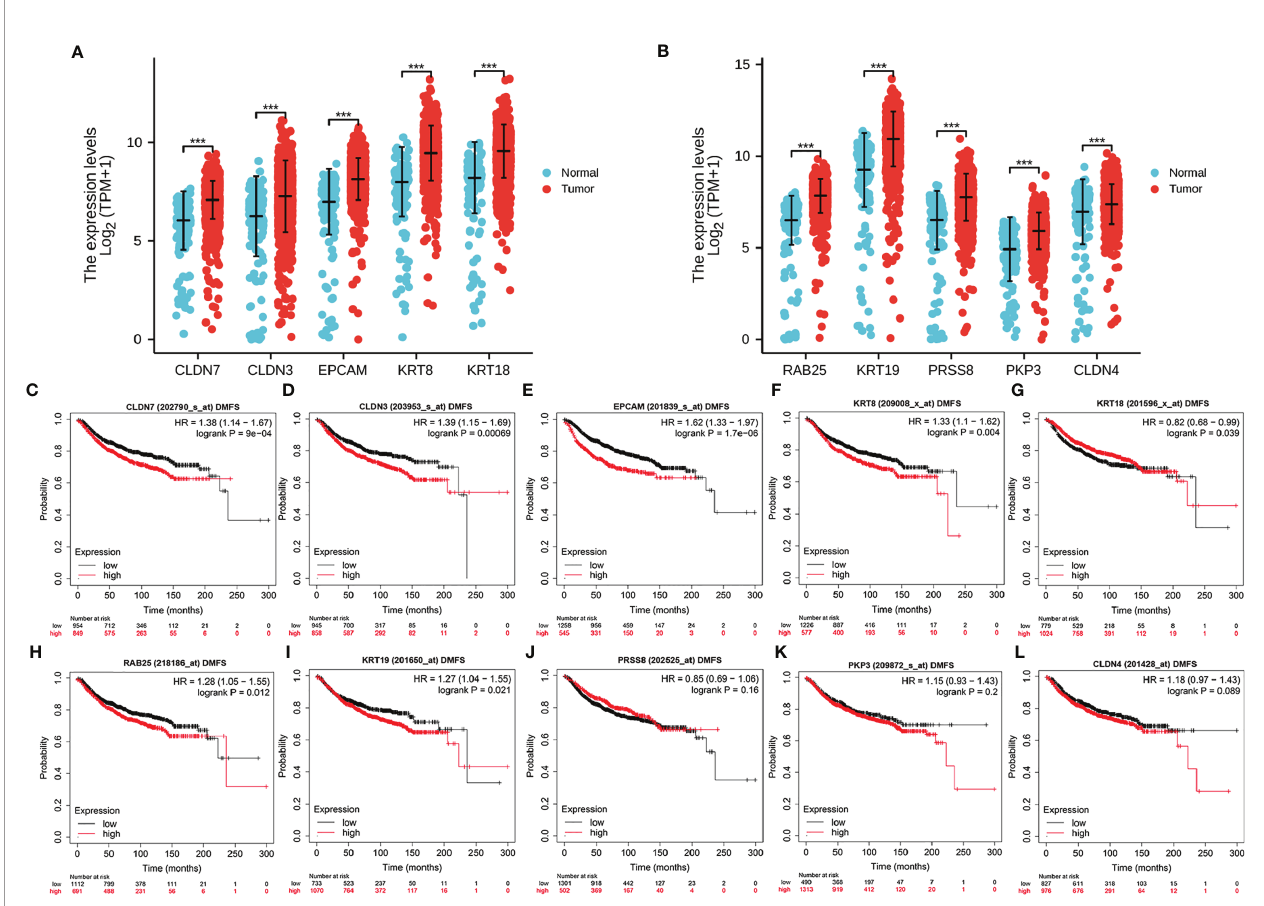
FIGURE 9 | Expression and prognostic signi fi cance of the hub genes in TCGA. Differential expression of the 10 hub genes (A, B) in breast cancer. The correlation between patient DMFS and the expression of CLDN7 (C) , CLDN3 (D) , EPCAM (E) , KRT8 (F) , KRT18 (G) , RAB25 (H) , KRT19 (I) , PRSS8 (J) , PKP3 (K) and CLDN4 (L) . *** P <